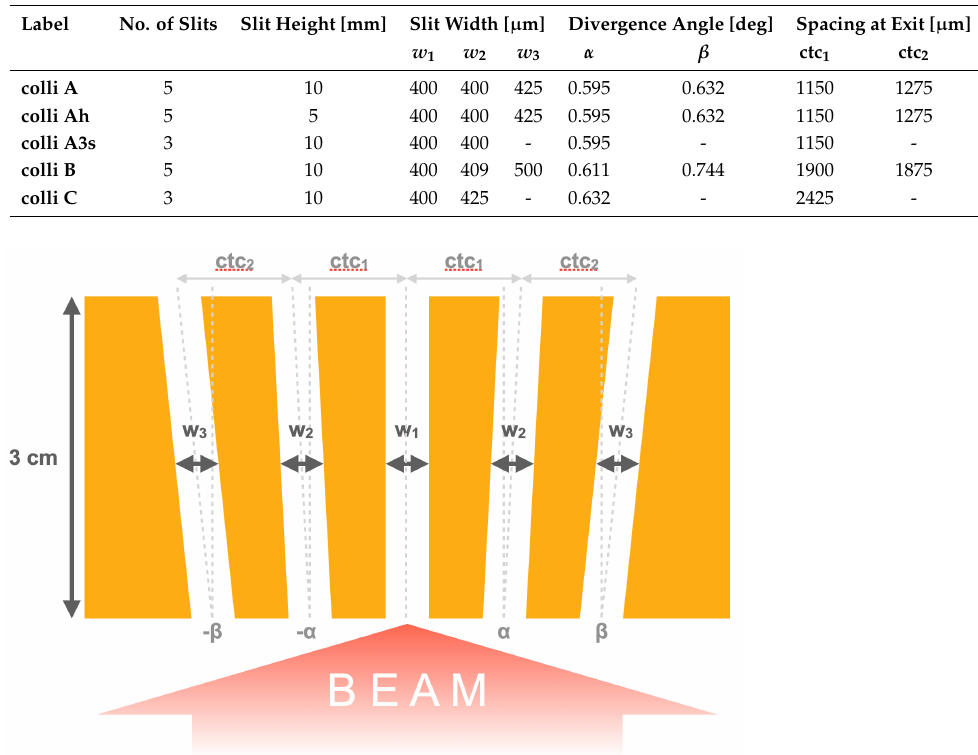
Table 1. Dimensions of the considered collimator geometries. The slit widths ( w 1 − 3 ), divergence